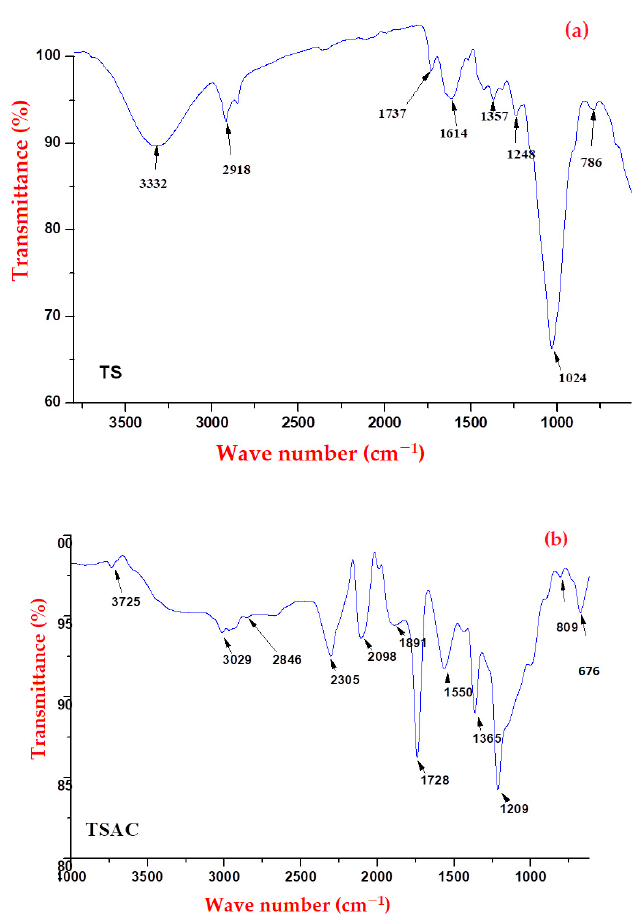
Figure 7. FTIR analysis results for Raw TS ( a ) and TSAC ( b ).